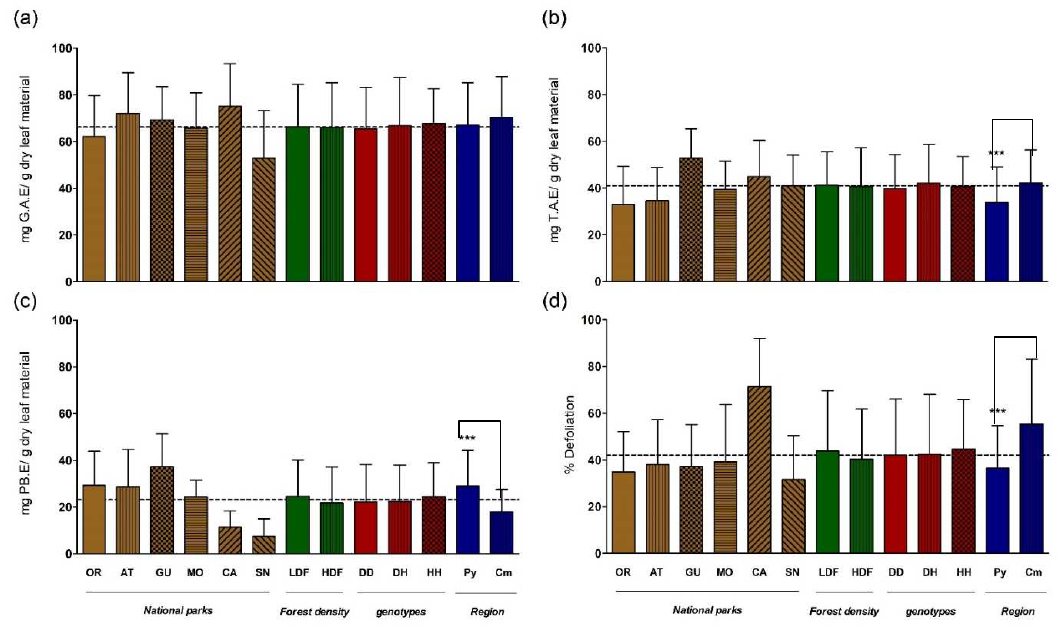
Figure 3. Constitutive levels of: ( a ), total phenolics or TP; ( b ), total tannins or TT; ( c ), condensed tannins or CT; and ( d ), percentage of defoliation in leaves of Quercus ilex. Trees were grouped by their singularities based on: biogeography, Pyrenean (PY) and continental-Mediterranean (cM); for- est density, high-density forest (HDF) and low-density forest (LDF); genotypes QUEil; MYB-like-1 D165 homozygous (DD), QUEil;MYB-like-1 H165 homozygous (HH), and QUEil;MYB-like-1 D/H165 heterozygous (DH). The bars in the graph represent the mean plus standard error. The dashed line indicates the mean value of the measured samples. The significance of the differences was statistically assessed by using a two-tailed alternative t -test. *** p < 0.001 (confidence level 99.9%). Regional (cM vs. Py), habitat type (LDL vs. HDL), and genetic (QiMYB-like-1 D165H polymorphism) interactions depending on the distribution of quantitative traits related to biotic stress were only evident for CT content and herbivory index, while TT content only showed highly significant variation ( p < 0.001) with respect to regional grouping (Table 3). Thus, we observed that herbivory susceptibility varied by region ( p < 0.001) and its interaction with genotype (G × R, p < 0.027)) and with density (R × D, p < 0.001), although not by all three simultaneously. Similarly, the CT content shows significant differences at the regional ( p < 0.001), ecological ( p < 0.003), and genetic ( p < 0.033) levels, individually and according to the GxD interaction ( p < 0.028), although also not for all the three varia- bles simultaneously (Table 3). Furthermore, QiMYB-like-1 H165 homozygous (HH) trees grown in low-density forests accumulate higher amounts of CT, while plants from the cM region are more prone to attack by herbivores when located in low-density forests or shar- ing the QiMYB-like-1 homozygous D165 genotype (DD; Figure 4). Table 3. Interaction effects (two-way ANOVA) of genotype, region, and forest density on chemical defense production and herbivore susceptibility. Cases 1